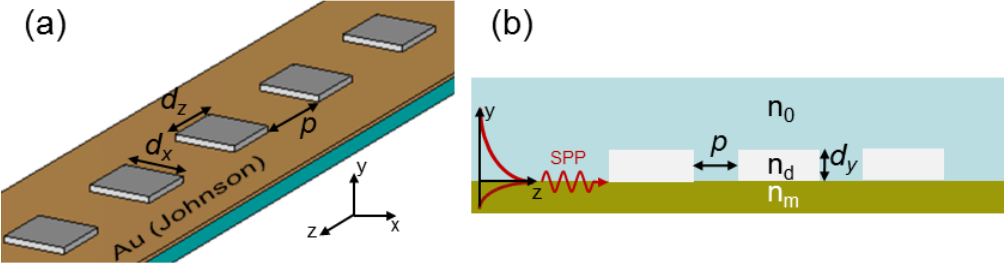
Figure 1. Schematic representation of the cuboid chain: ( a ) perspective and ( b ) lateral view. The dielectric cuboids have dimensions d x × d y × d z and are periodically placed along the z -axis with an air gap p between them.